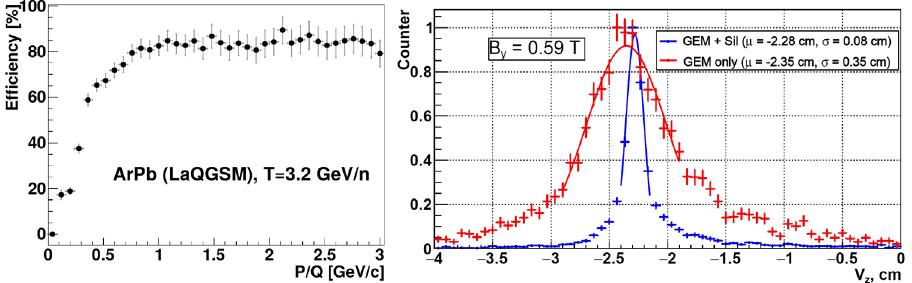
Fig. 4. Tracking efficiency and vertex resolution obtained in quality assurance